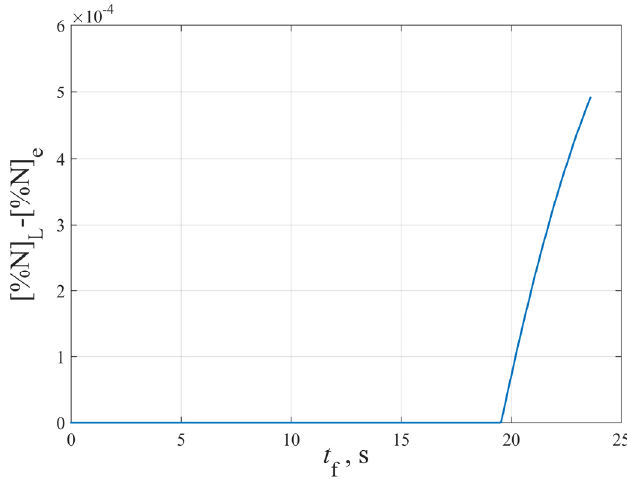
− [ %N ] and the solidification time t f e